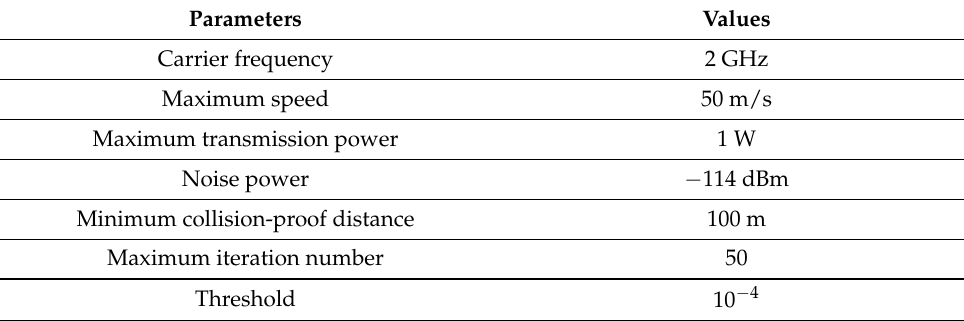
Table 2. Simulation parameters. Parameters